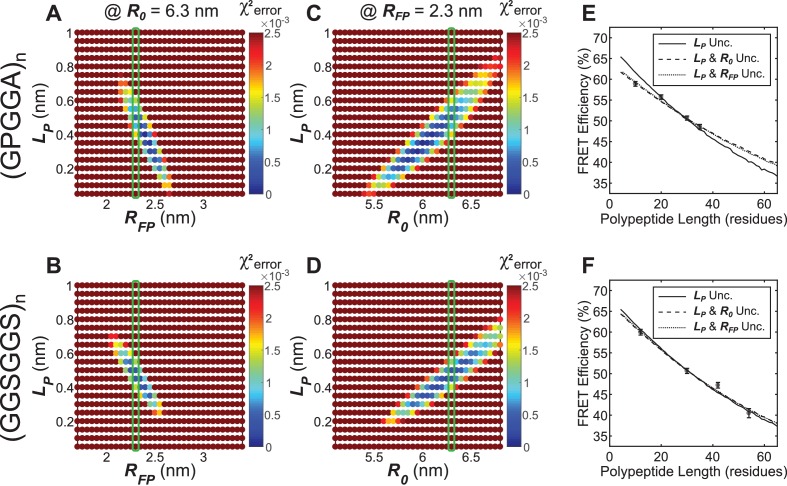
Parameter constraint has minimal effects on measurement of polypeptide persistence length (LP) in cellulo.(A, B) Heatmaps of chi-squared error of model fits to in cellulo “minimal” Clover-mRuby2 based TSMod FRET-length measurements for various RFP and LP for (GPGGA)n (A) and (GGSGGS)n (B) extensible domains; literature estimate of RFP used for parameter constraint highlighted with green bar; R0 is constrained to 6.3 nm. (C, D) As in panels (A and B), except various R0 and LP parameters were examined; green bar highlights R0 parameter estimate; RFP is constrained to 2.3 nm. (E, F) Model fits to in cellulo FRET-length relationships for ‘minimal’ Clover-mRuby2 based TSMods containing the (GPGGA)n (E) or (GGSGGS)n (F) extensible domain are equally accurate with either a single unconstrained (unc.) parameter (LP) or two unconstrained parameters.